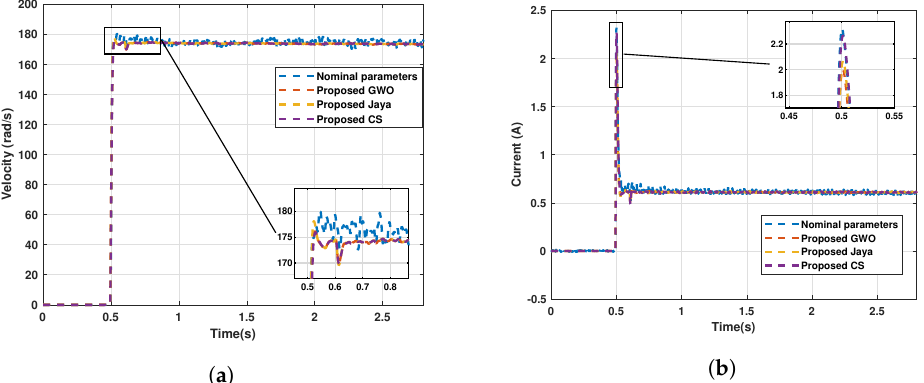
Figure 17. Comparison between the three modified algorithms for experimental signals. ( a ) Compari- son between velocities estimates and acquired velocity; ( b ) Comparison between currents estimates and acquired